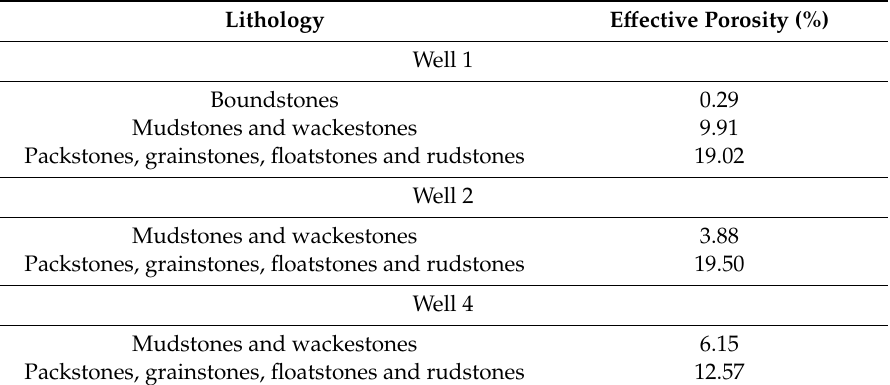
Table 5. Variability interval of porosity in the Main Dolomite subfacies in well sections [25,83].